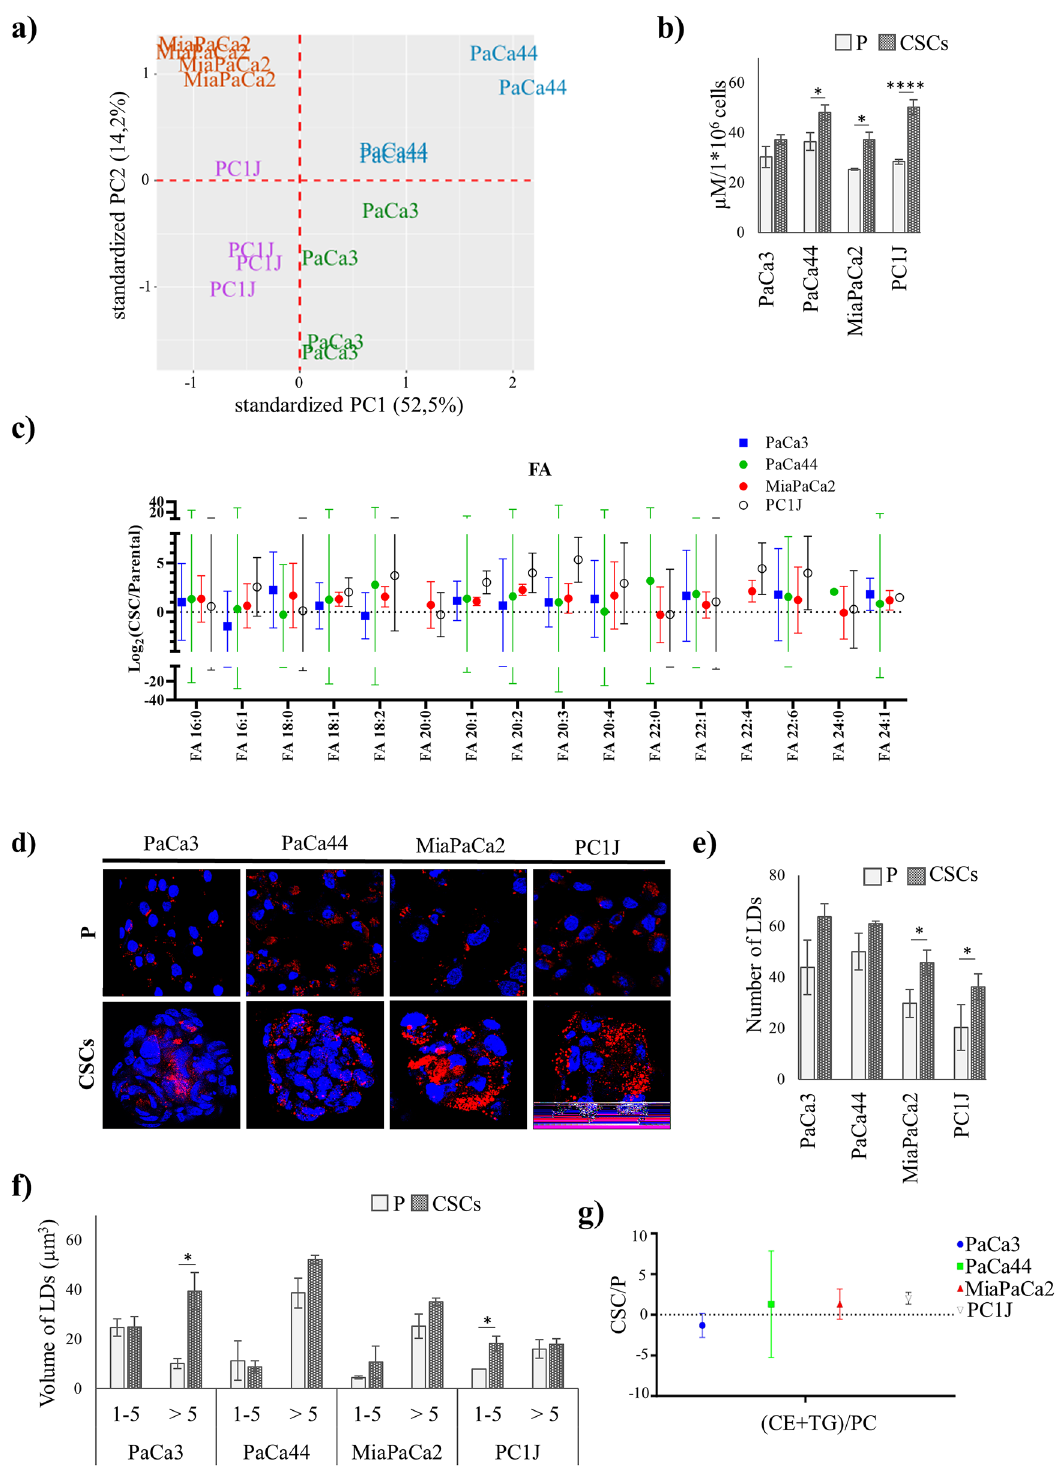
Figure 3. Accumulation of fatty acids and lipid droplets in PCSCs. ( a ) Principal component analysis (PCA) of lipid profile of PaCa3, PaCa44, MiaPaCa2, and PC1J CSCs against P cells. Analysis of FAs as detected by ( b ) FFA Quantification kit and ( c ) LC–MS/MS-based lipidomics (bars show mean fold change ± 95% confidence intervals). ( d ) Representative confocal microscopy images of PCSCs and P cells labelled with Oil Red O (red) to detect LDs, and with DAPI (blue) to highlight nuclei. Measure of ( e ) number and ( f ) size (as volume, μm 3 ) of LDs obtained following imaging cells (data are presented as means ± standard error (SE) of three independent experiments); ( g ) analysis of CE + TG content (normalized on PC) detected by LC–MS/MS-based lipidomics (bars show mean fold change ± 95% confidence intervals). p < 0.05 (*) and p < 0.0001